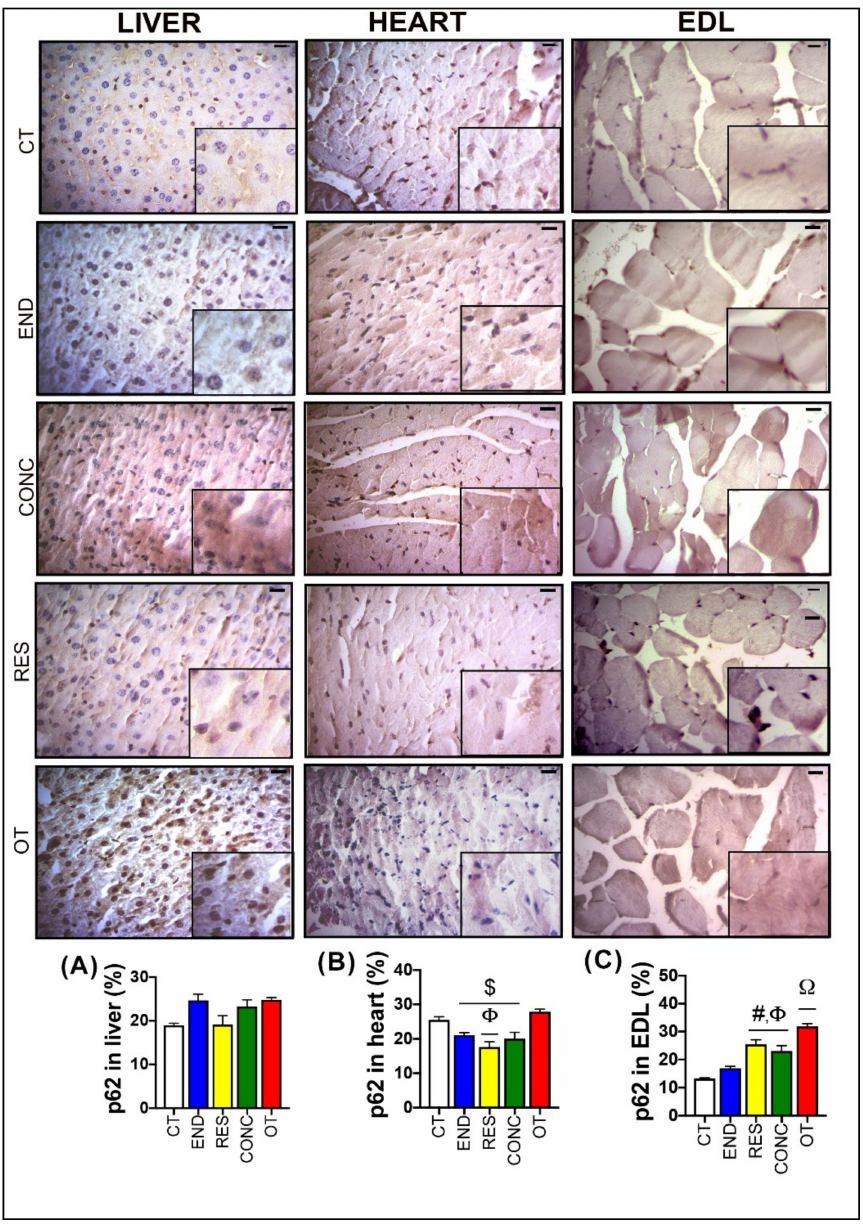
Figure 4. p62 expression by immunohistochemistry in the liver ( A ), heart ( B ), and EDL ( C ). Data correspond to mean ± SEM of 4–5 mice / group. Bar = 20 µ m. Highlight 1.5 × zoom. $ p ≤ 0.05 vs. OT. Φ p ≤ 0.05 vs. CT. # p ≤ 0.05 vs. END. Ω p ≤ 0.05 vs. all the other experimental groups. CT (Sedentary; control group); END (Endurance; submitted to the chronic endurance exercise protocol); RES (Resistance; submitted to the chronic resistance exercise protocol); CONC (Concurrent; submitted to the chronic concurrent exercise protocol); OT (Overtraining; submitted to the chronic